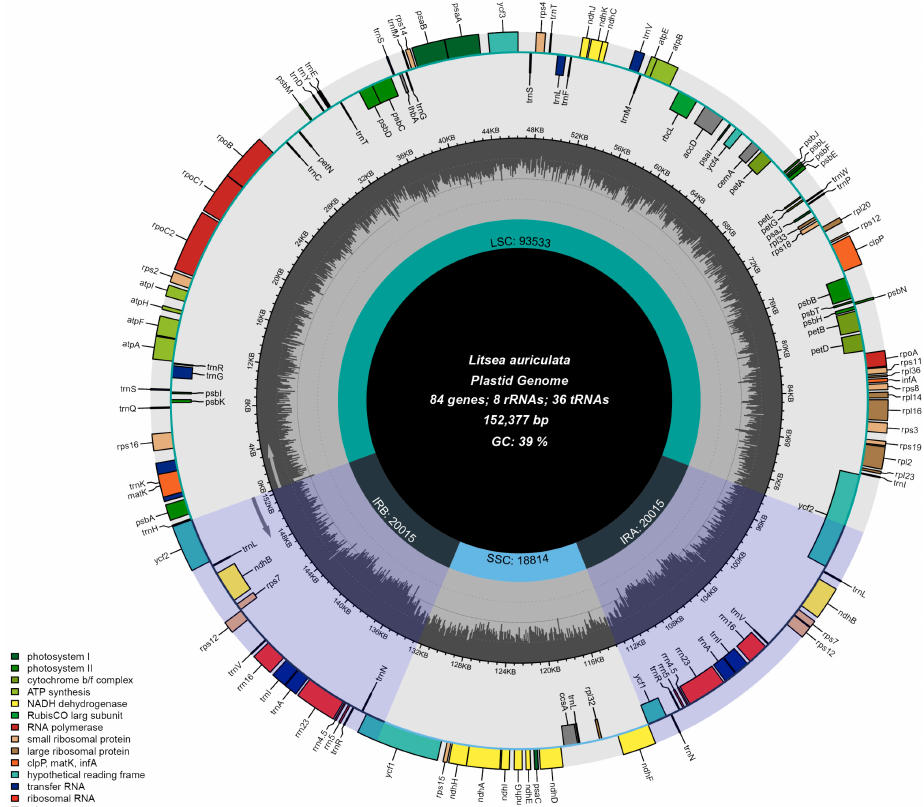
Figure 1. Circular map of chloroplast genome of Litsea auriculata with annotated genes. Genes shown inside and outside of the circle are transcribed in clockwise and counterclockwise directions, respectively. Genes belonging to different functional groups are color-coded. The GC and AT content are denoted by the dark gray and light gray colors in the inner circle, respectively. LSC, SSC, and IR are large single-copy region, small single-copy region, and inverted repeat region,